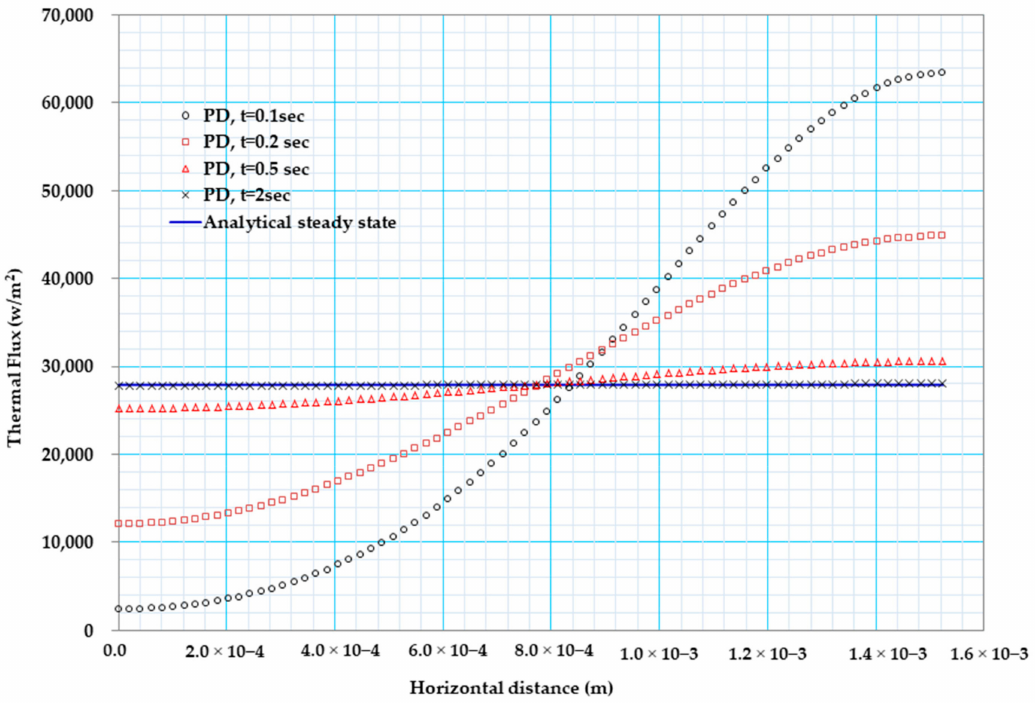
Figure 11. Heat flux (w / m2) distribution of bismuth telluride pellet.